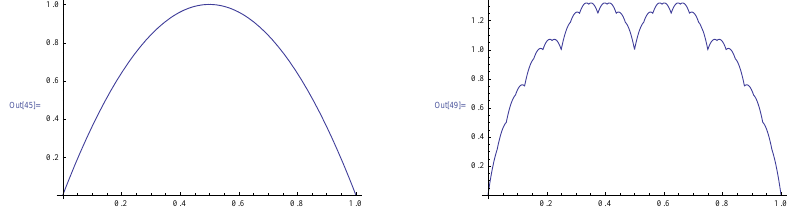
Figure 1. The hybrid τ − q attractor. It is smooth at one scale ( Left ), but fractal at another ( Right